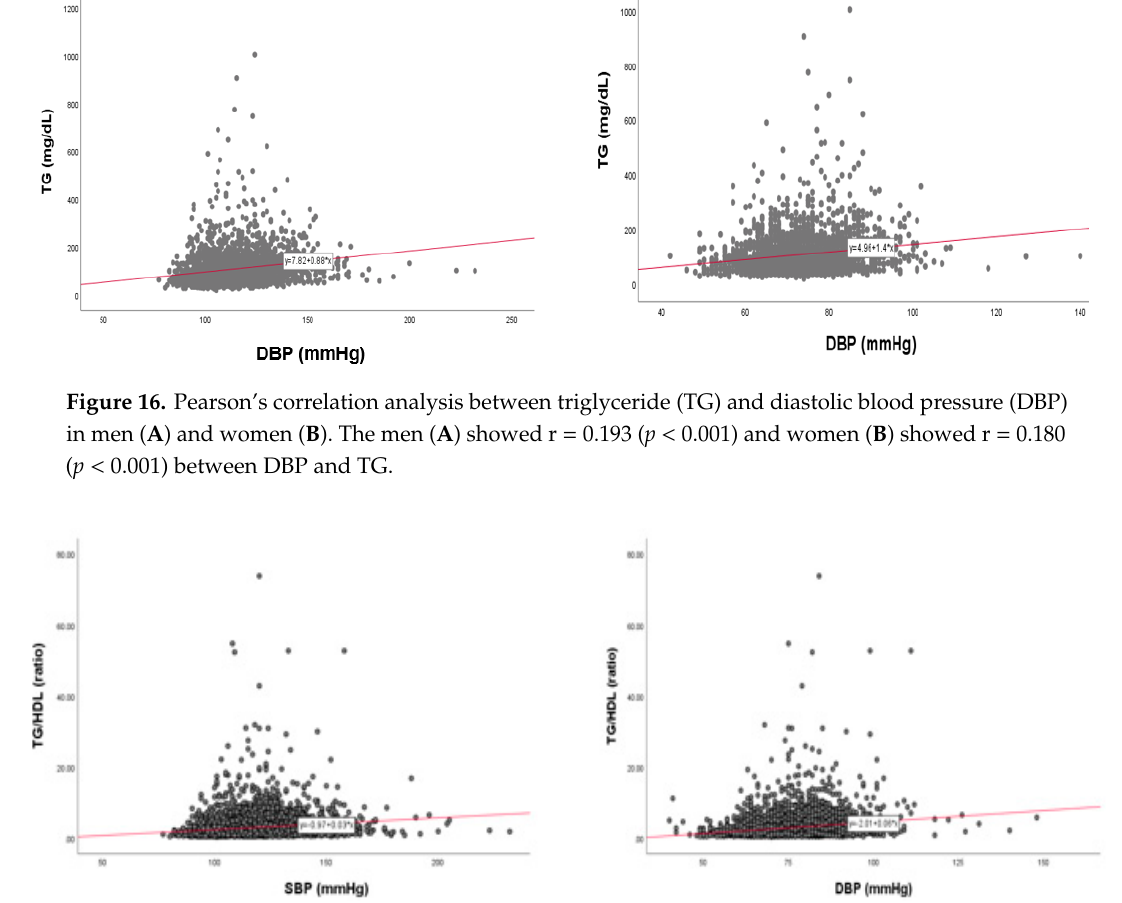
Figure 17. Pearson’s correlation analysis between TG / HDL ratio and systolic blood pressure (SBP, panel A ) and diastolic blood pressure (DBP, panel B ) in total population ( n = 4552). Panel A showed a positive correlation (r = 0.156, p < 0.001) between SBP and TG / HDL ratio; Panel B showed a positive correlation (r = 0.194, p < 0.001) between DBP and TG / HDL ratio.